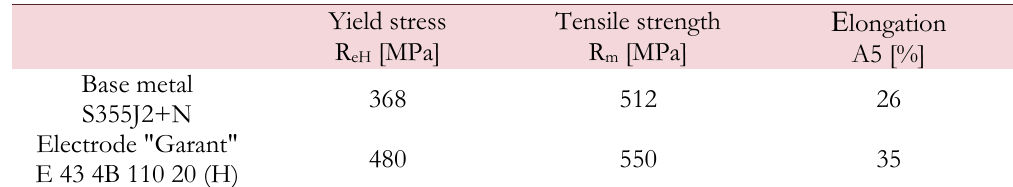
Table 1: Mechanical properties of base metal and